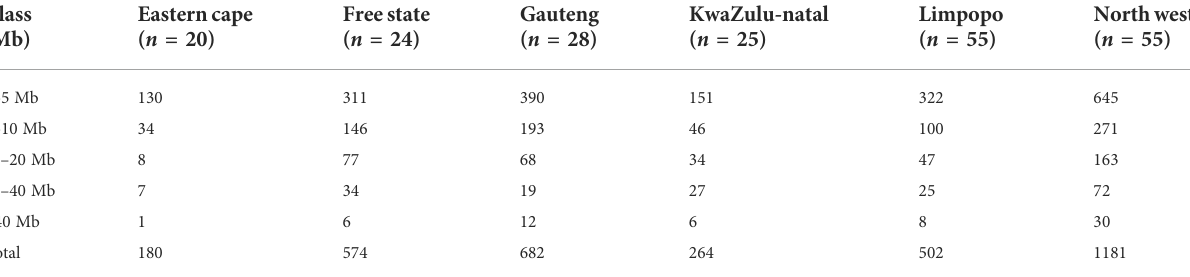
TABLE 2 Number of runs of homozygosity ( n ROH) and length (in Mb) categorized by ROH length class (ROH 1 – 5 Mb, ROH 5 – 10 Mb , ROH 10 – 20 Mb, ROH 20 – 40 Mb and ROH > 40 Mb